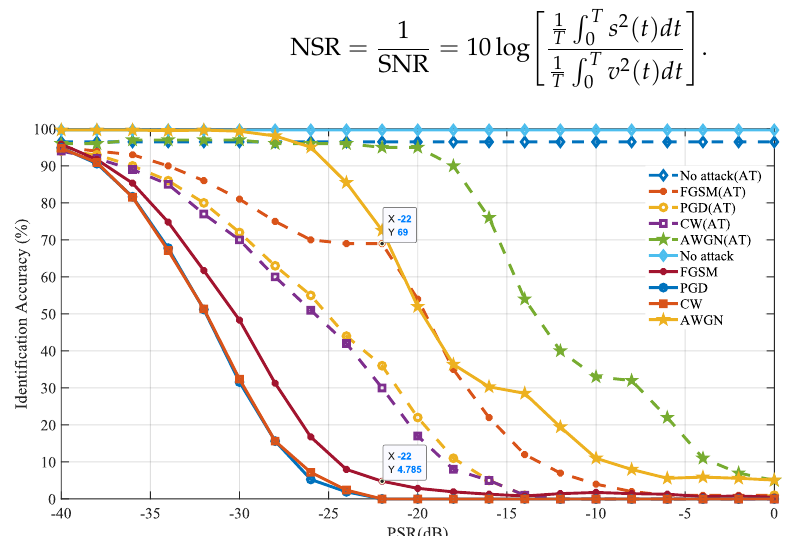
Figure 17. Recognition effect of the system with and without AT for different attack strengths, different attack types and noise levels for Dataset